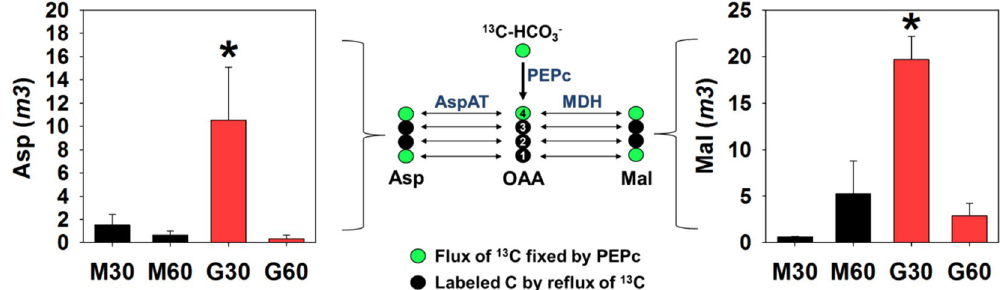
Figure 2. Evidence for the higher anaplerotic CO2 fixation in G cells in comparison to M cells. M cells (black bars) and G cells (red bars) were fed with 13 -NaHCO 3 and harvested after 30 min and 60 min in the light. The abundance of mass isotopomers of aspartate m3 (left side) and malate m3 (right side) in mesophyll cells (M) or guard cells (G) after 30 and 60 min in the light is displayed. The anaplerotic reaction catalysed by phospho enol pyruvate carboxylase (PEPc) and the subsequent steps catalysed by aspartate aminotransferase (AspAT) and malate dehydrogenase (MDH) are highlighted in the center of the figure. Small spheres represent carbon atoms labelled directly by the activity of PEPc (green spheres) or by the reflux of this 13 C by the activity of the tricarboxylic acid cycle (black spheres). Asterisks indicate values that are significantly different between mesophyll and guard cells by Student’s t -test ( P < 0.05) in the same time point. Data presented are mean ± standard deviation ( n =